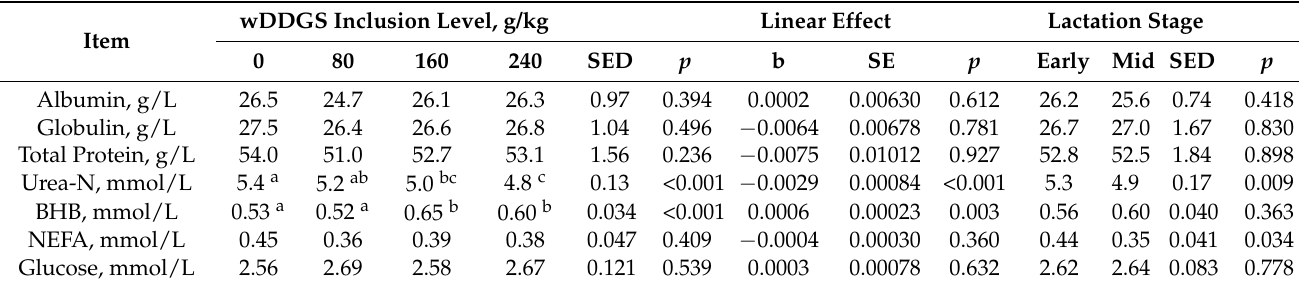
Table 4. (Experiment 1) Mean plasma metabolites of cows in early or mid-lactation when fed on diets containing 0 to 240 g wDDGS DM/kg diet DM.